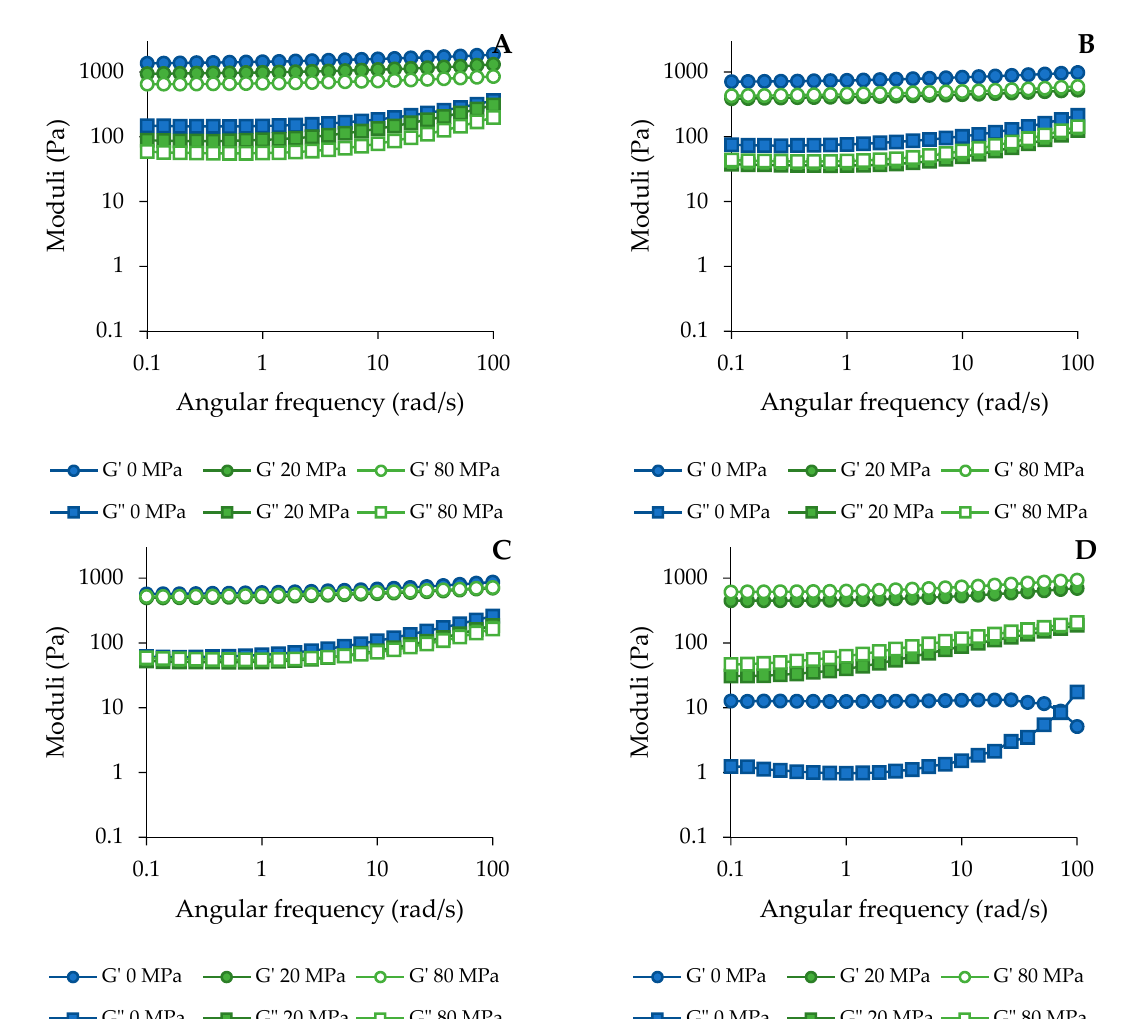
Figure A1. Storage modulus (G ′ ) and loss modulus (G ″ ) in function of the angular frequency (frequency sweep) at strain 0.1% of the suspensions prepared with the acid-unextractable fraction of apple ( A ), carrot ( B ), onion ( C ) and pumpkin ( D ) before (0 MPa) and after high-pressure homogenization at 20 and 80 MPa. Abbreviations The following abbreviations and symbols were used in the manuscript.